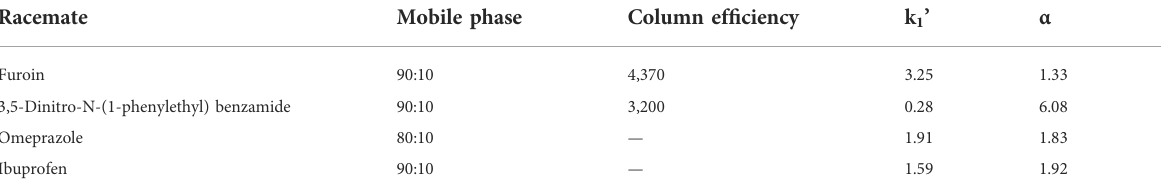
TABLE 3 Different racemates separations on the MOF-packed column. Reproduced with permission from (Xie et al., 2014). Racemate Mobile